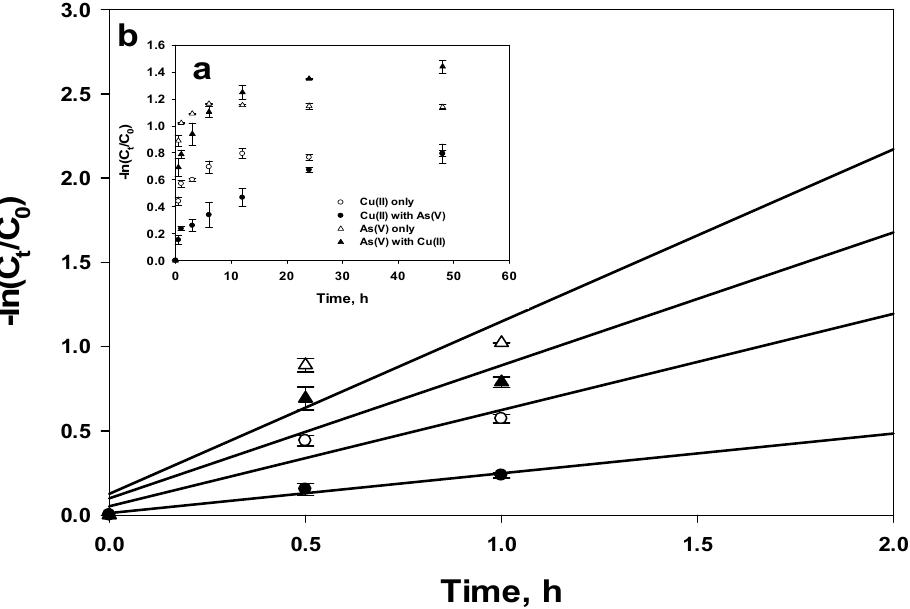
Figure 8. Spahn and Schlunder film diffusion model shown for ( a ) the entire experimental time scale and ( b ) less than 2 h.